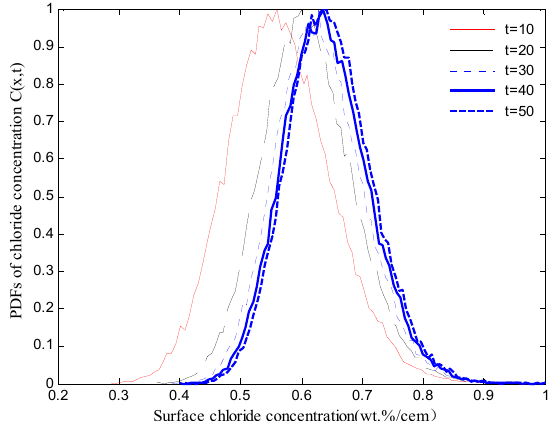
Figure 2. PDFs of the chloride concentration C ( x , t ) .